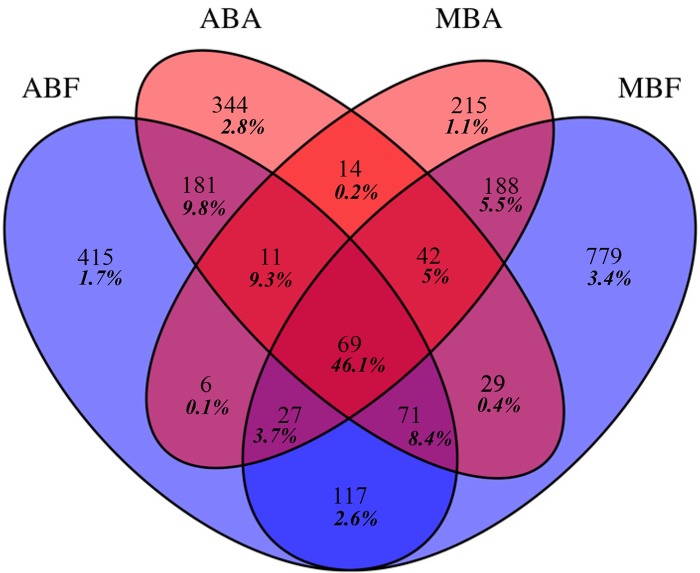
Distribution of the first 100 dominant bacteria OTUs at the order level, expressed as the proportion of the average number of reads obtained from each sample after normalization to the smallest sample. (n = 3402 reads).Circle size indicates the abundance relative to the whole sample for each cyanobacterial species: Anabaena (AB) and Microcystis (MB)) and fraction: free living (F) or associated (A) bacteria.